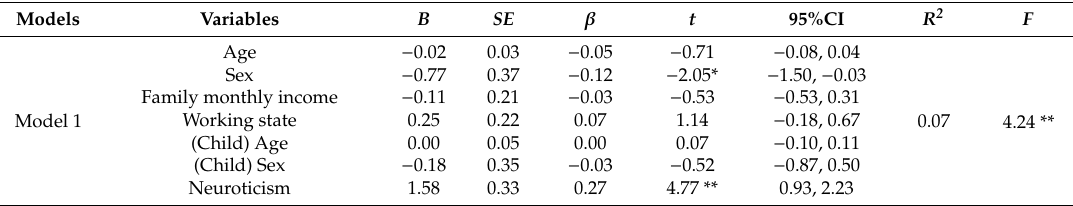
Table 4. Hierarchical linear regression analysis among parents of children with a visual or hearing